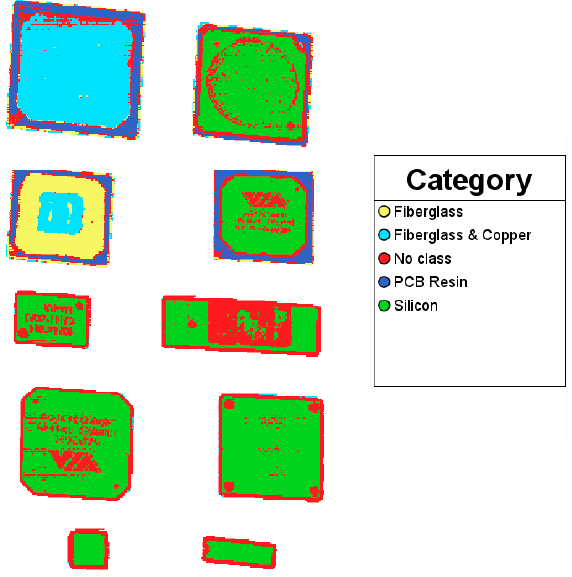
Figure 7. PLS-DA category model of the identified objects.